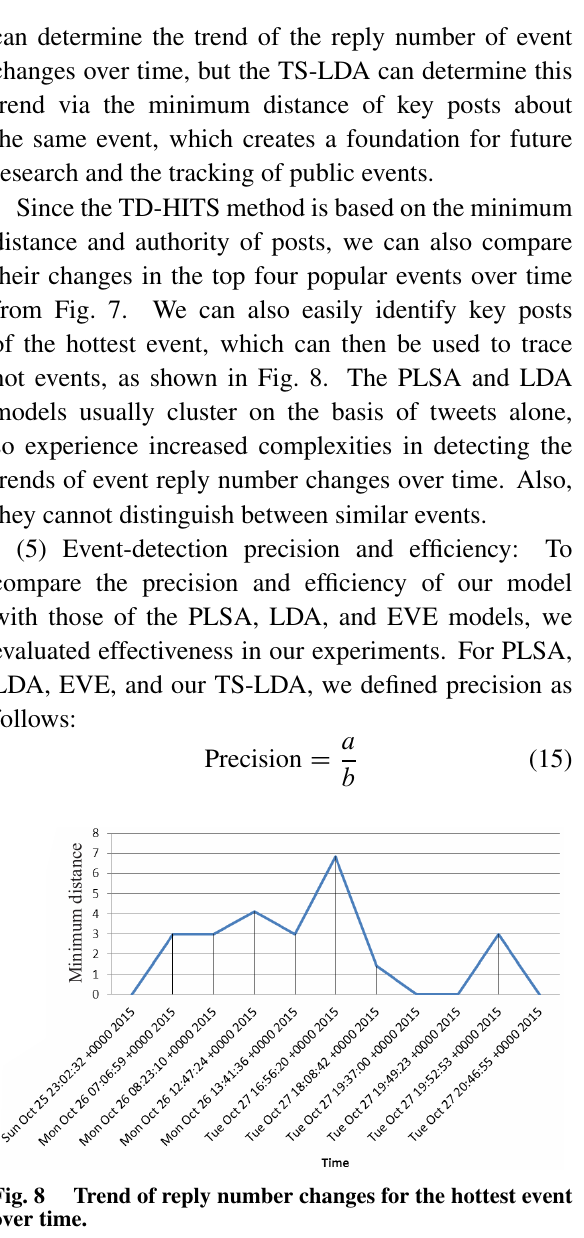
Fig. 7 Trends in reply number changes of top four popular events over time.